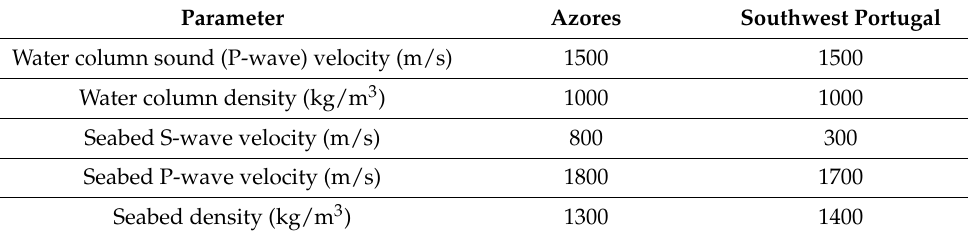
Table 2. Properties of the water column and the seabed of the Azores and southwest Portugal deployment